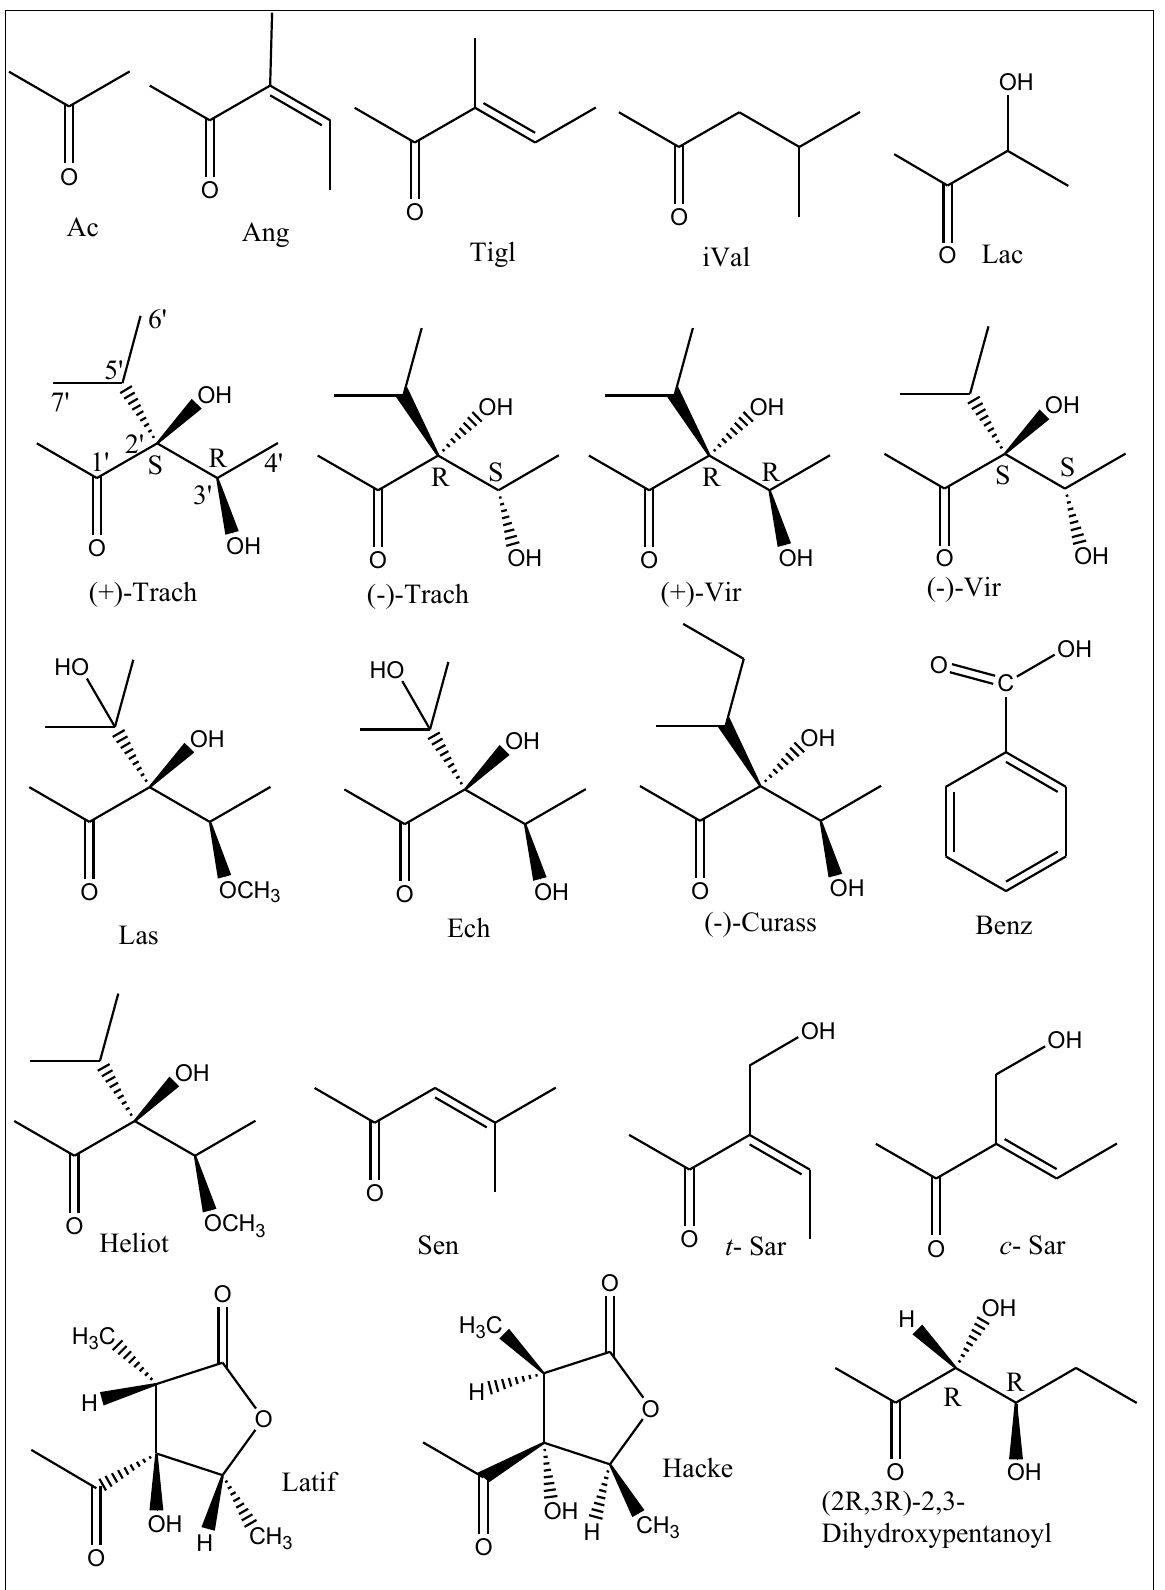
Figure 2. Necic acids occurring in pyrrolizidine alkaloids of